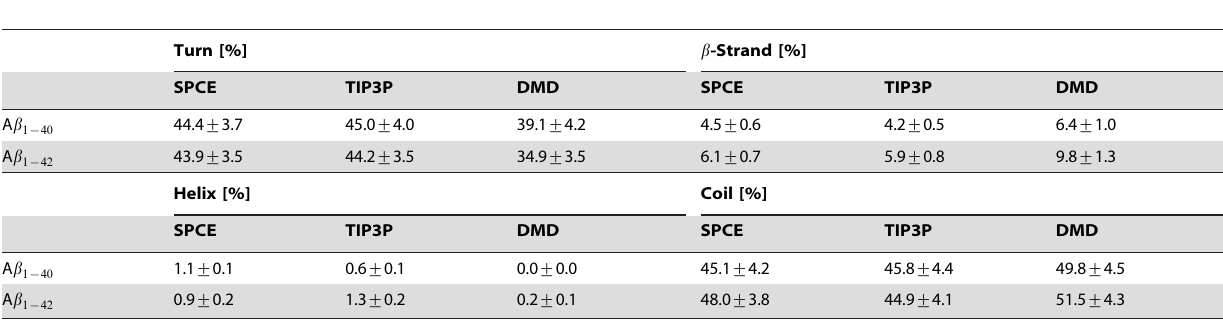
Table 2. Average turn, b -strand, helical, and coil propensities within A b approach with each of the two water models and the DMD approach.